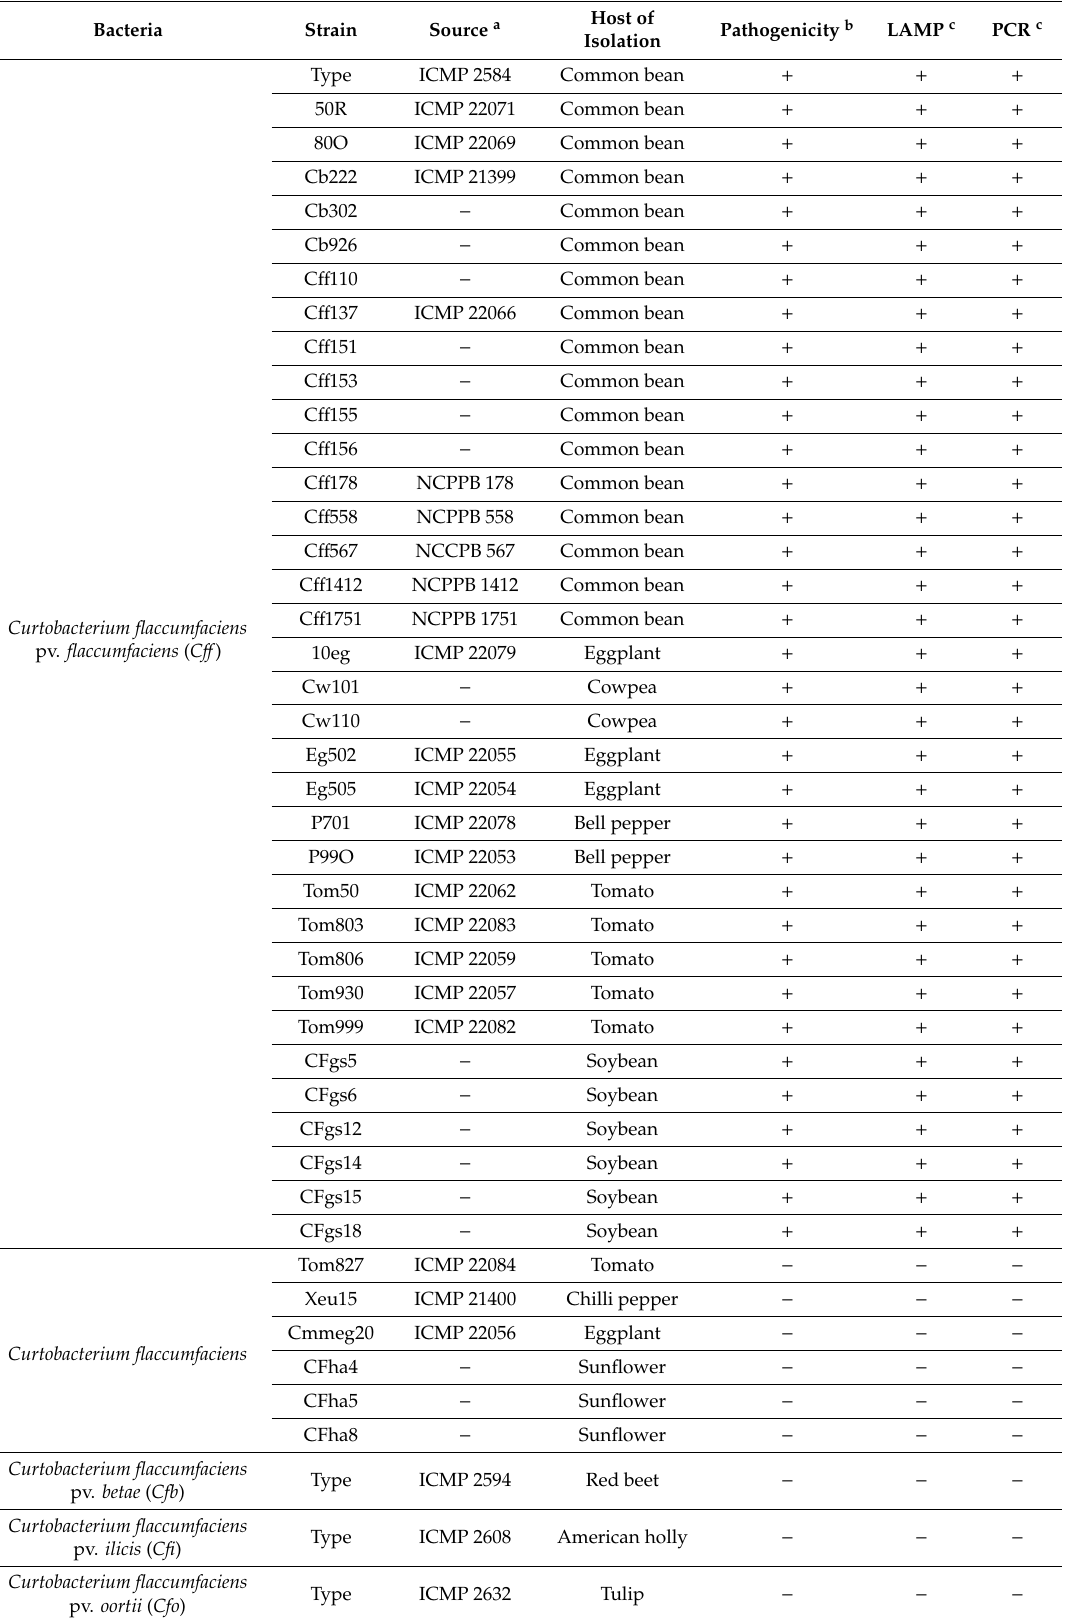
Table 1. Bacterial strains used in this